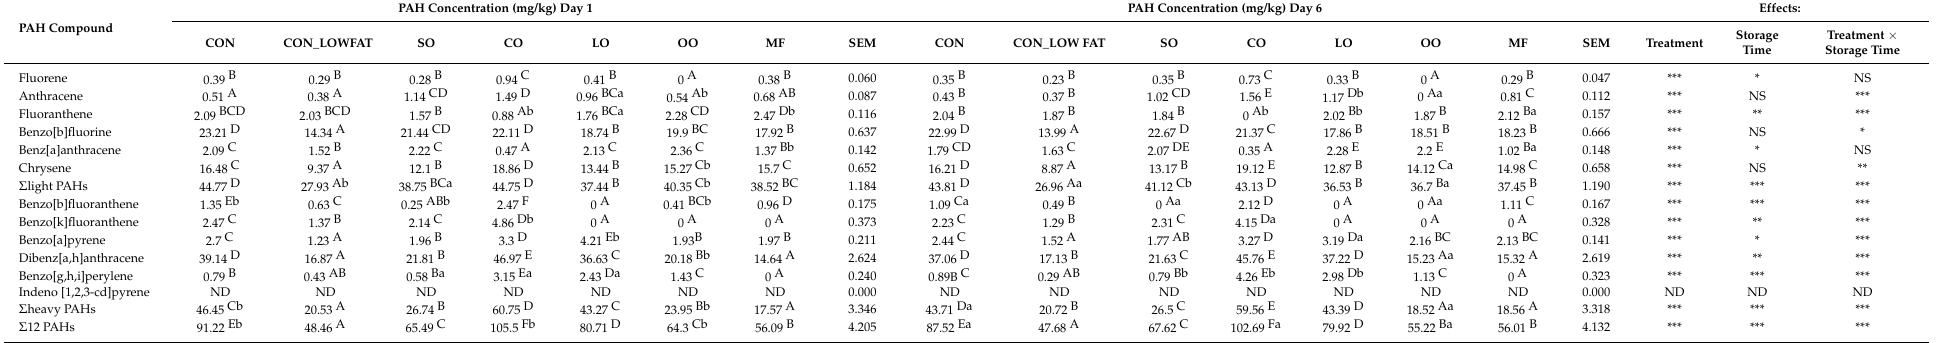
Table 7. PAHs formation in grilled burgers on day 1 and day 6 of storage (mean ± SE).